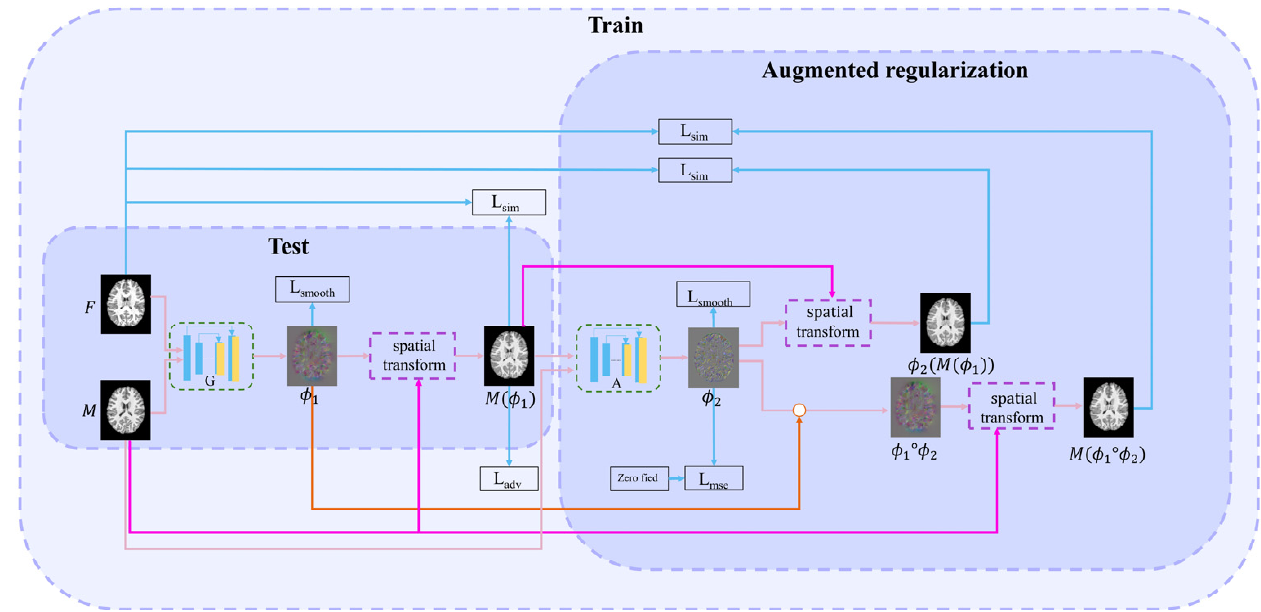
Figure 1. Overall network framework.